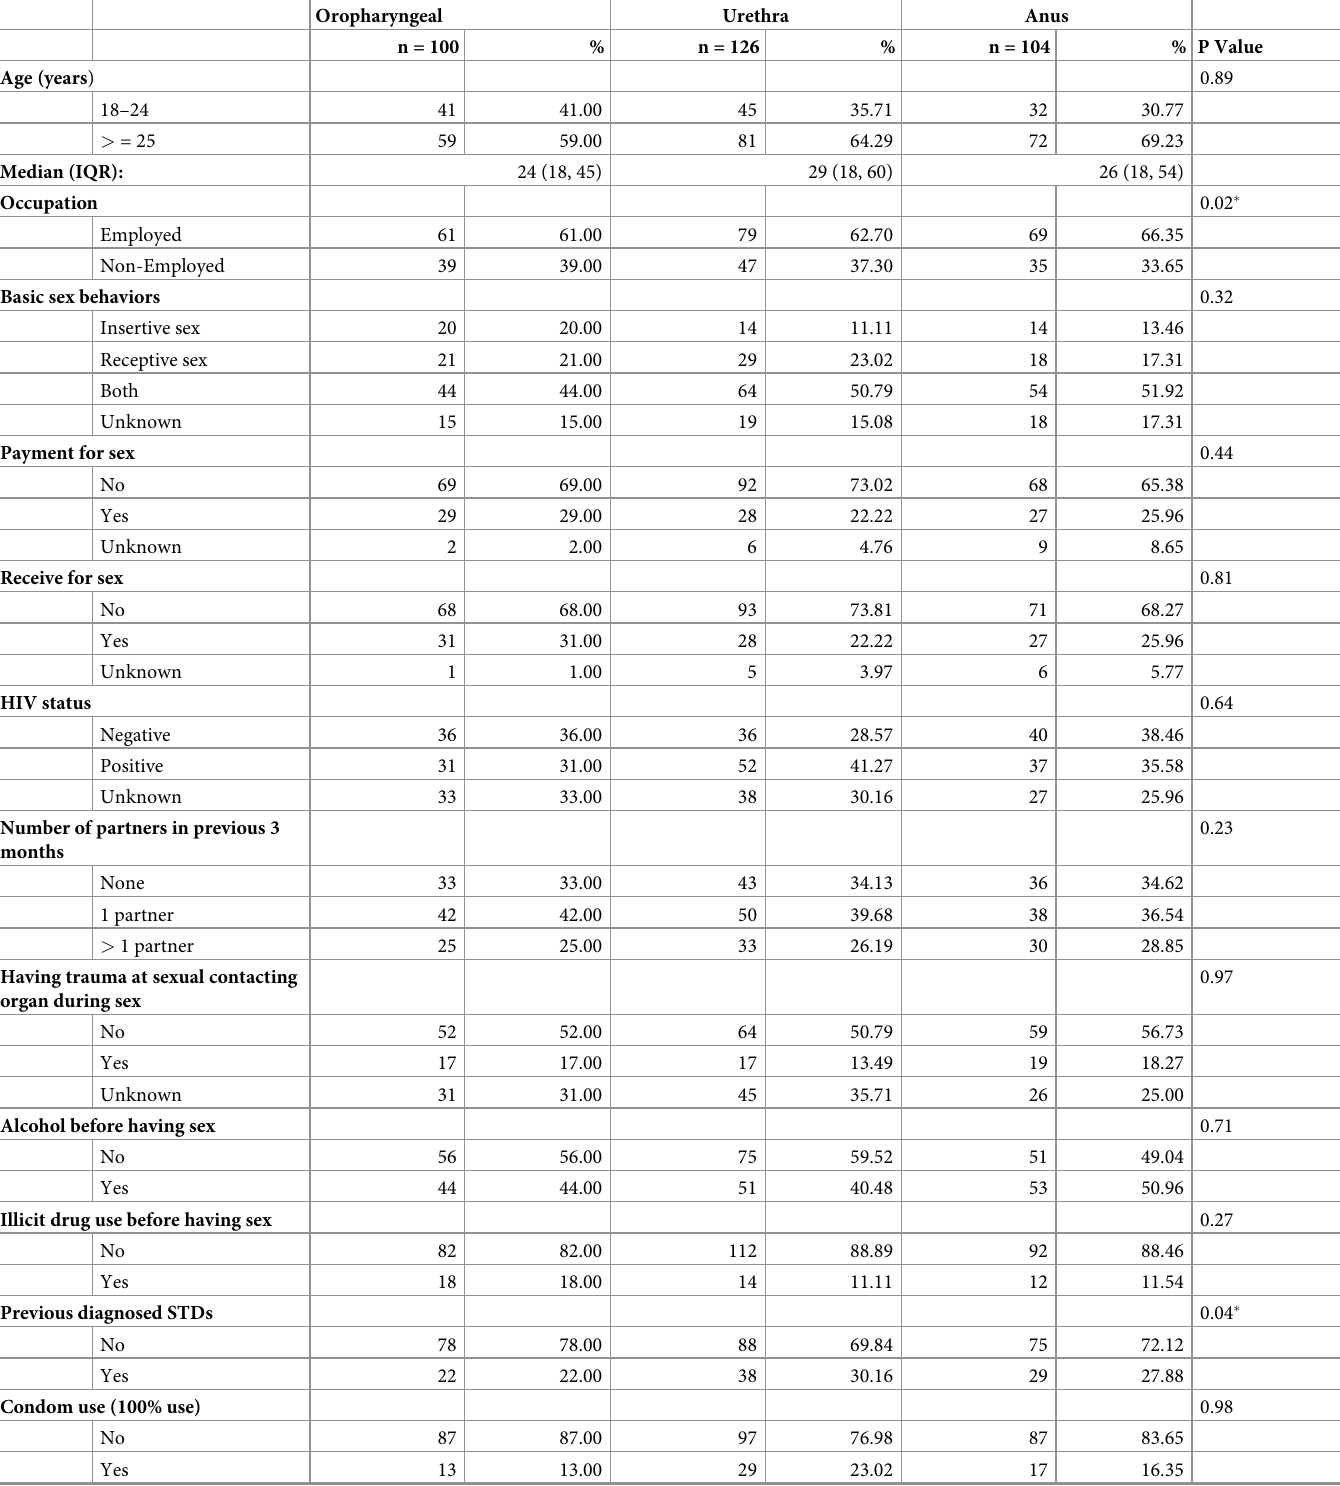
Table 2. Basic characteristics of participants by anatomic distributions of positive results using PCR with TaqMan probes.